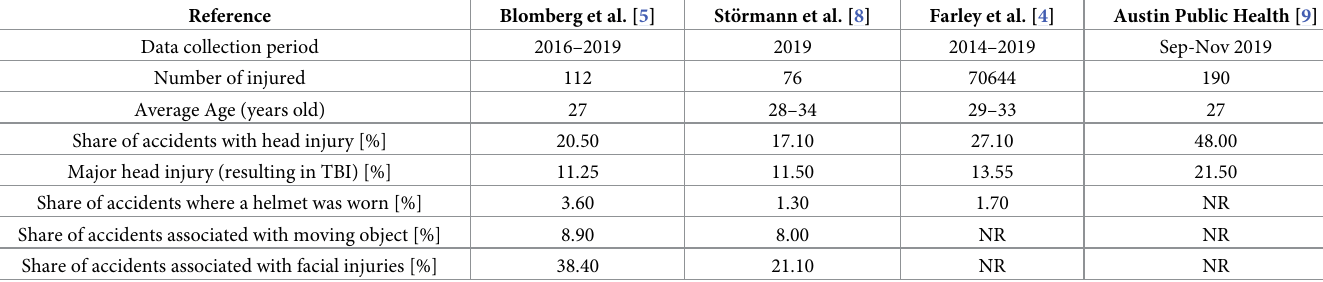
Table 1. A summary on e-scooter-related types of accidents, injuries percentages and helmet use, NR—Not reported.